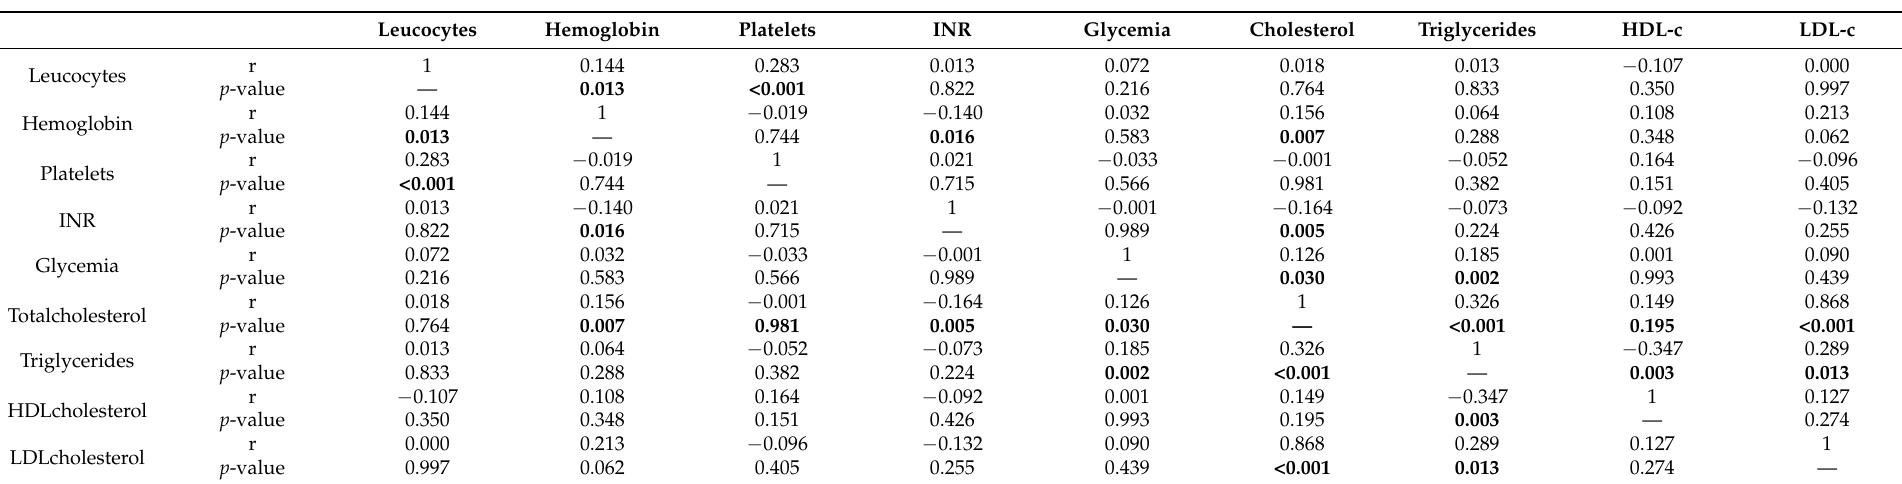
Table 10. Pearson correlation between other paraclinical